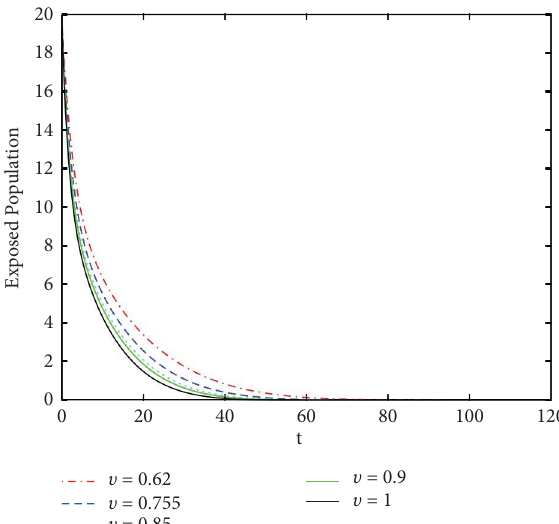
Figure 13: Te dynamics of recovered human population for various fractional orders υ and for fractal order π � 0 . 5.